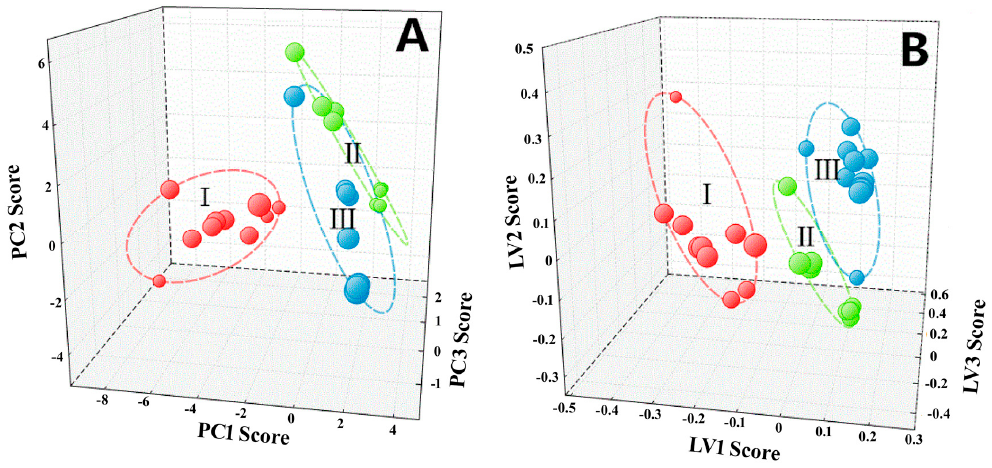
Figure 5. PCA score plots and PLS-DA of Pyrrosiae Folium by HPLC ( A ) PCA; ( B ) PLS-DA. ( I : Pyrrosia sheareri ; II : P. lingua ; III : P. petiolosa ).